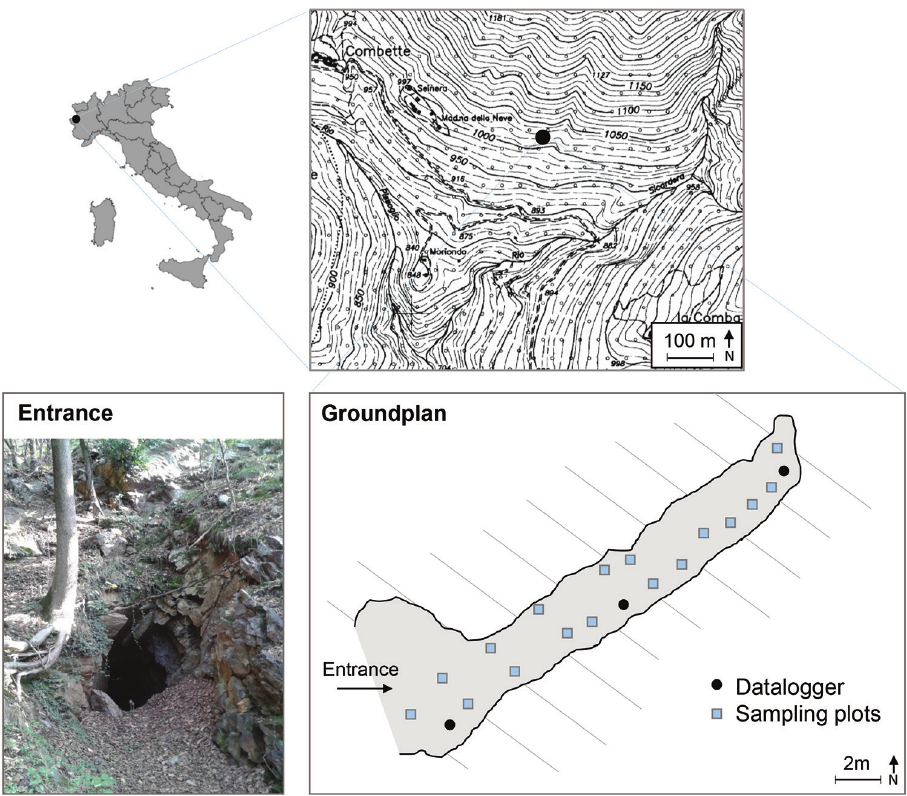
Figure 1. Map of the study area and groundplan of the Seinera mine, with indication of sampling plots and